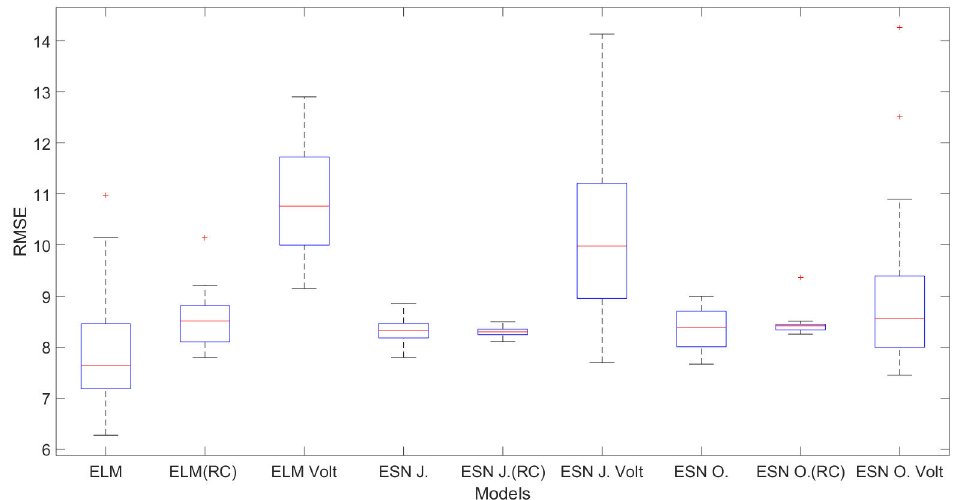
Figure 6. Boxplot graphic regarding the RMSE values for São Paulo-Lag 2. For São Paulo, the general behavior of the standard models was similar to Campinas.